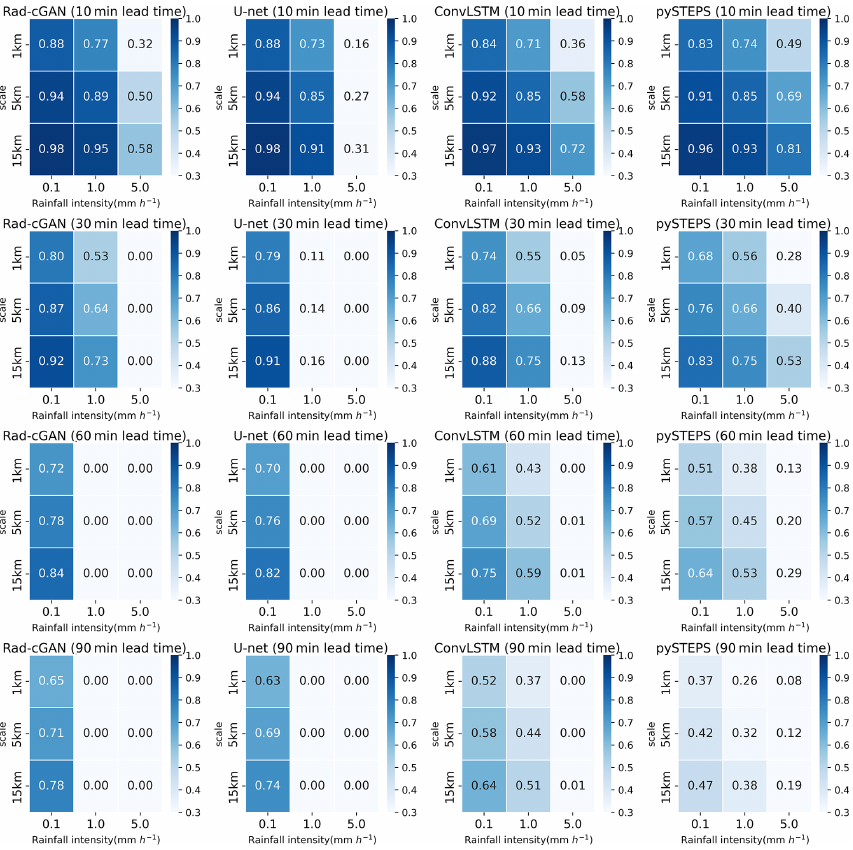
Figure 4. Fraction skill scores (FSS) of model predictions at lead times of 10, 30, and 60min at Soyang-gang Dam basin. Panels from left to right express FSS of Rad-cGAN, U-net, ConvLSTM, and pySTEPS